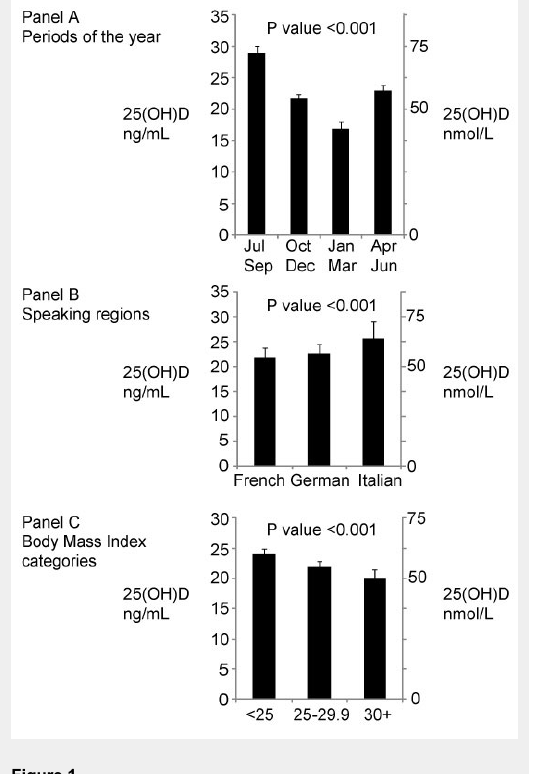
Figure 1 Adjusted mean 25(OH)D levels. A By period of the year. B By speaking region. C By BMI categories.